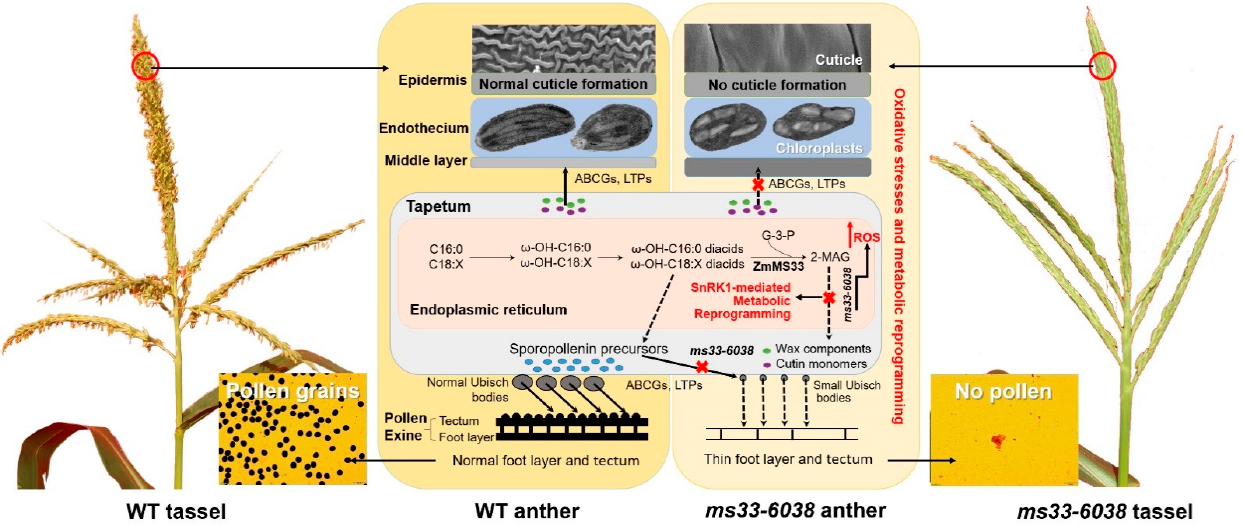
Figure 9. A reconstructed working mode underlying excessive phenotypic deficiencies in ms33-6038 anthers. ZmMs33 deficiency induces an excessive ROS accumulation and metabolic re- programming in tapetum, further impairs the expression and function of many other GMS genes, and finally leads to severe phenotypic deficiencies in the development of an anther wall and pol- len